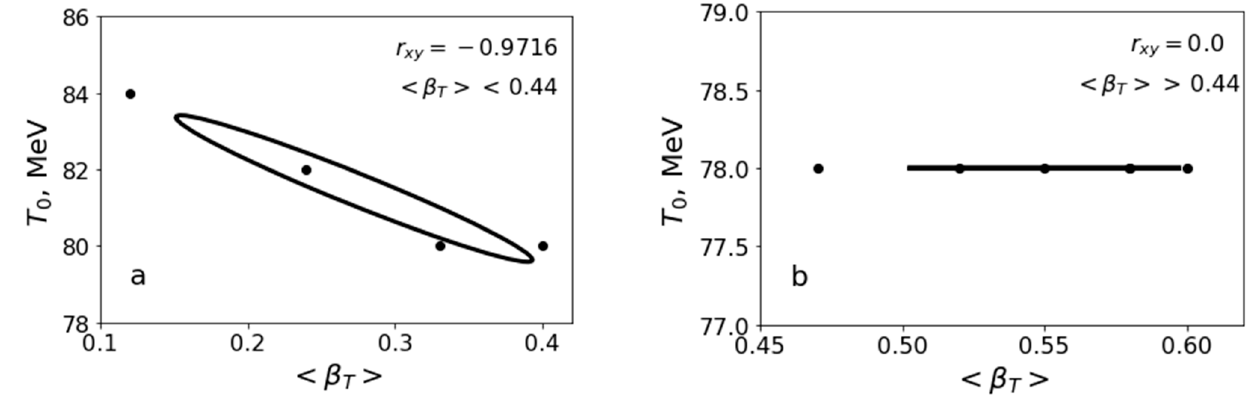
Figure 5. ( a )—Dependence ( • ) of T 0 versus (cid:104) β T (cid:105) parameters, extracted using Equation (5) and presented in Table 2, in region (cid:104) β T (cid:105) < 0.44. ( b )—Dependence ( • ) of T 0 versus (cid:104) β T (cid:105) parameters, extracted using Equation (5) and presented in Table 2, in region (cid:104) β T (cid:105) > 0.44. The corresponding 1-sigma confidence ellipses and Pearson correlation coefficients are also shown in the figures.